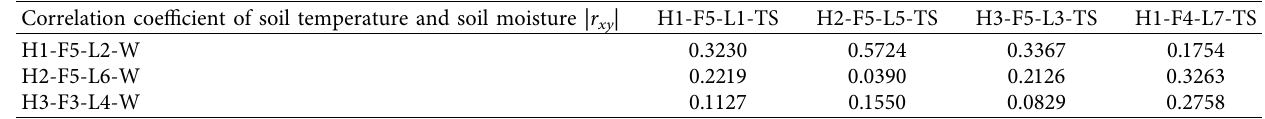
Table 5: Correlation coefficient of roadbed soil temperature and soil moisture.